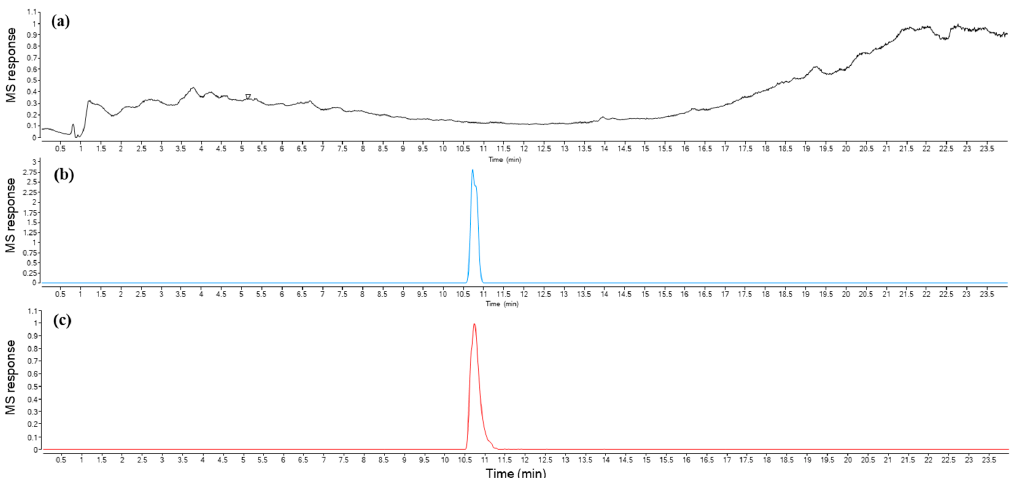
Figure 9. Representative UPLC-UV-QTOF chromatograms ( a ) total ion chromatogram for a brain sample of a rat treated with PJ; ( b ) selected ion chromatogram of m / z 227.0354 for a brain sample of a rat treated with PJ; ( c ) selected ion chromatogram of m / z 227.0354 for pure UA standard.